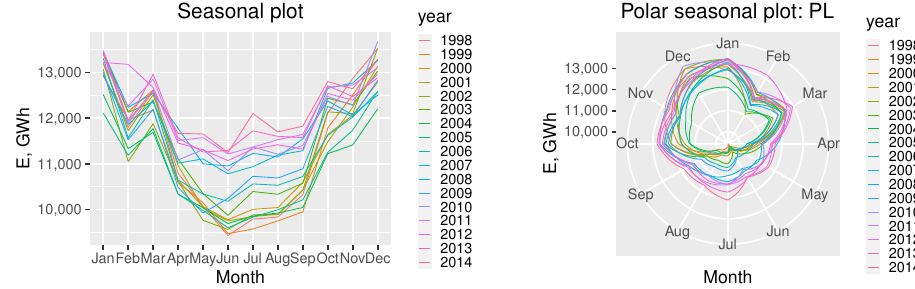
Figure 4. Seasonal MEL plots for